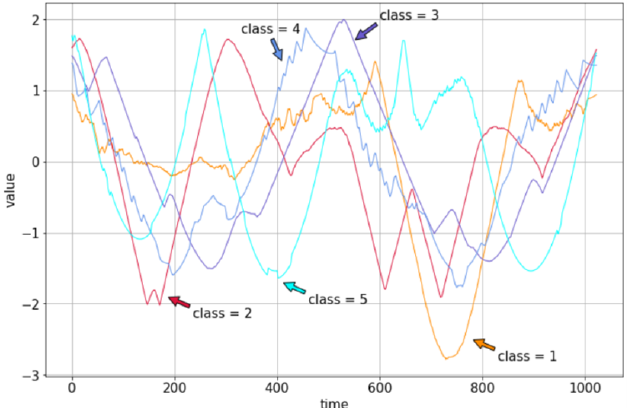
Figure 5. Comparison chart of different data classes.